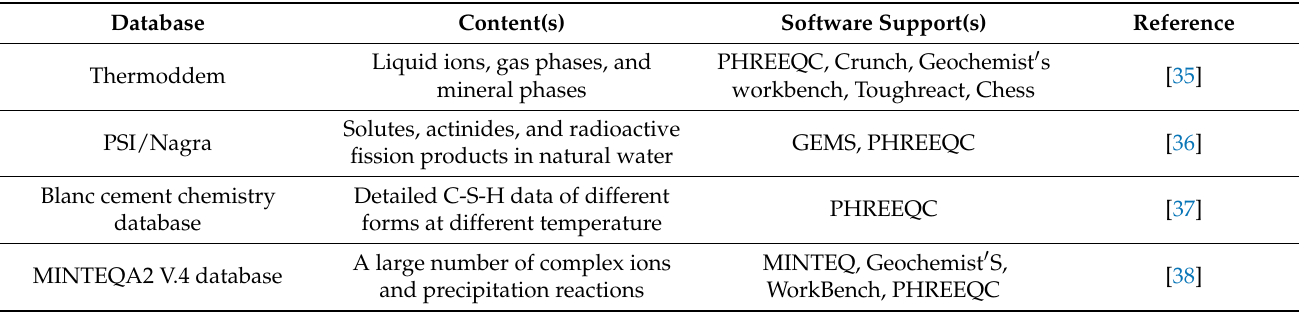
Table 1. A Comparison of different thermodynamic databases.